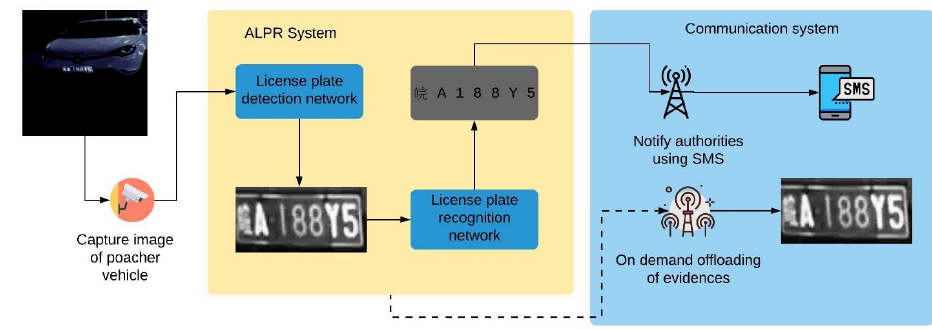
Figure 6. Data flow of the proposed